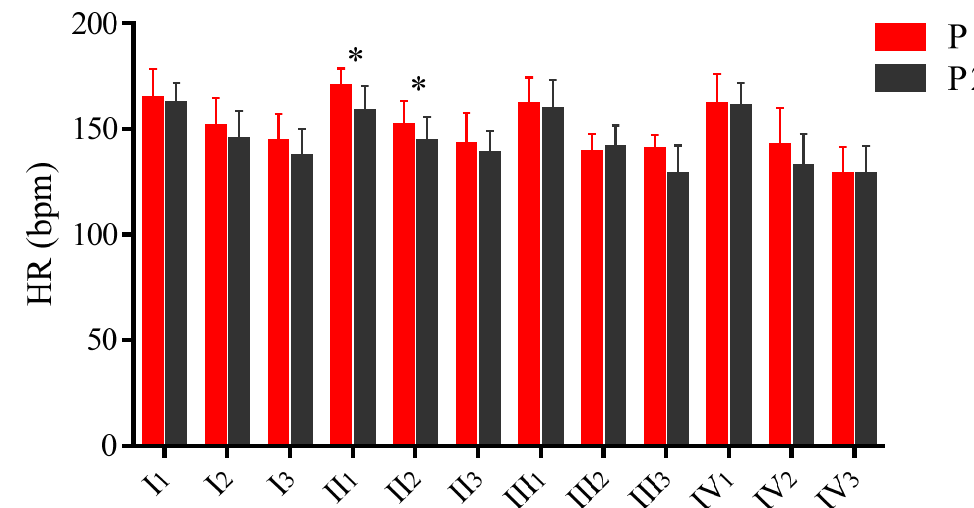
Figure 3. Heart rate recovery during 2 phases. Legend: I1—first minute of recovery in first round, I2—second minute of recovery in first round, etc.; P1—phase one: HISST combined with RWL; P2—phase two: HISST with no RWL procedures included; HR bpm—heart rate values; * statistically significant difference, p <